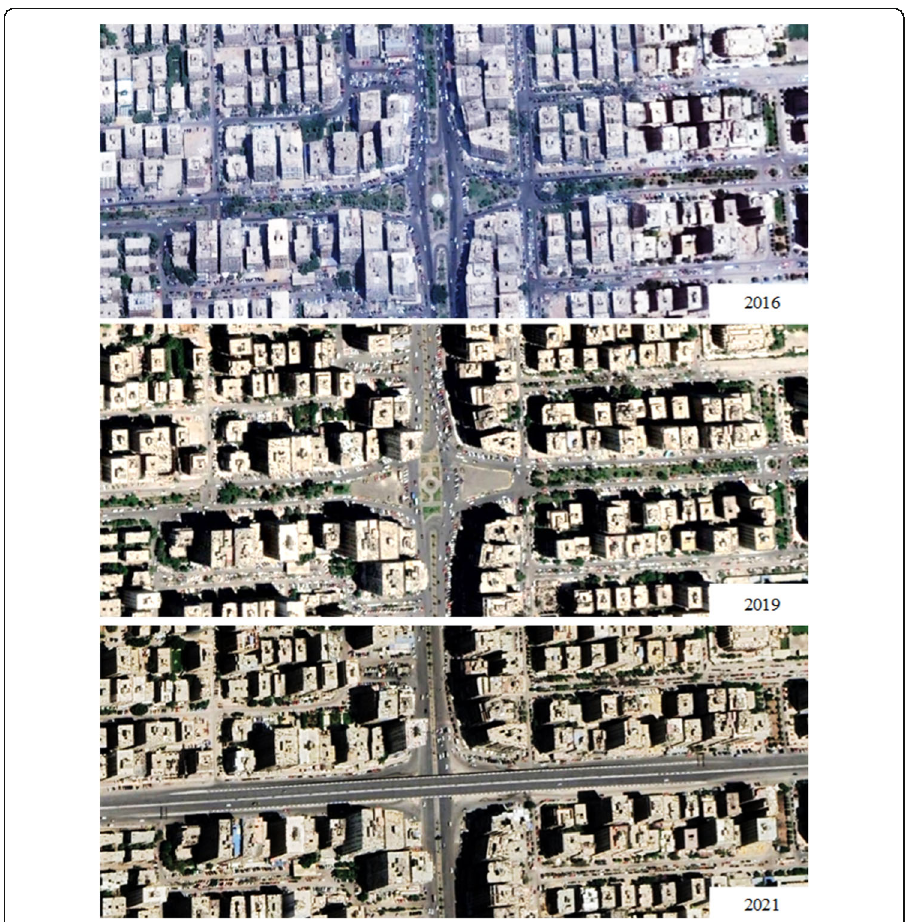
Fig. 10 Intersection of Abbas al-Aqad Street with al-Batrawy Street, Nasr City, Map data © 2021